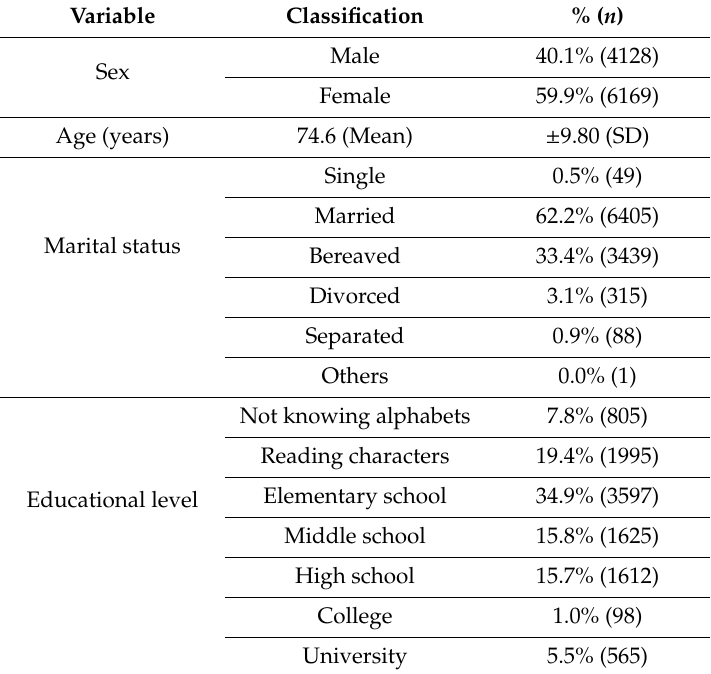
Table 1. General characteristics of the study